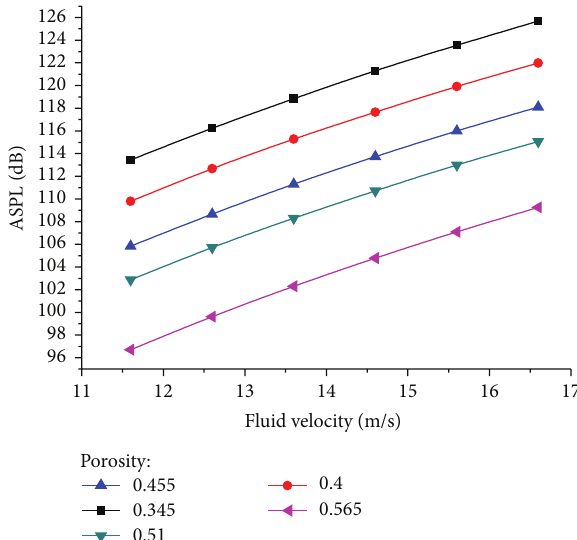
Figure 20: Relationship between the fluid velocity and the ASPL in different